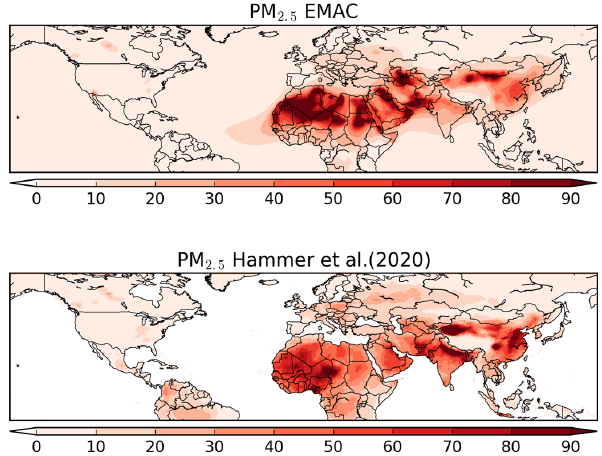
Figure 18. Global map of PM 2 . 5 from model results and the Ham- mer et al. (2020) dataset for the year 2010 (annual average, in µgm − 3 ). The data from Hammer et al. (2020) does not contain val- ues over the ocean.